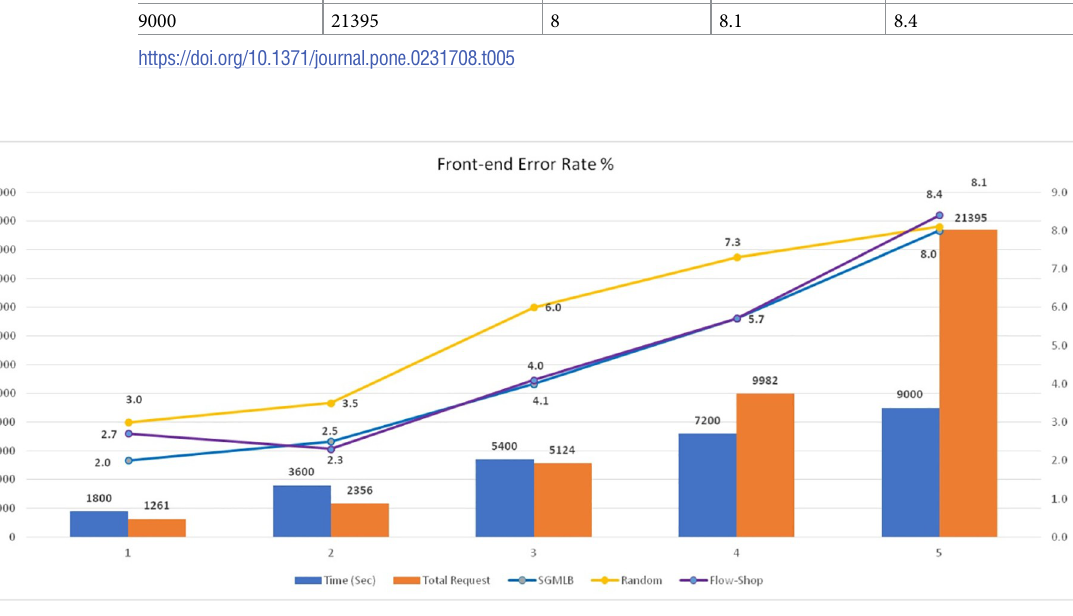
Fig 7. Front-end error rate analysis.